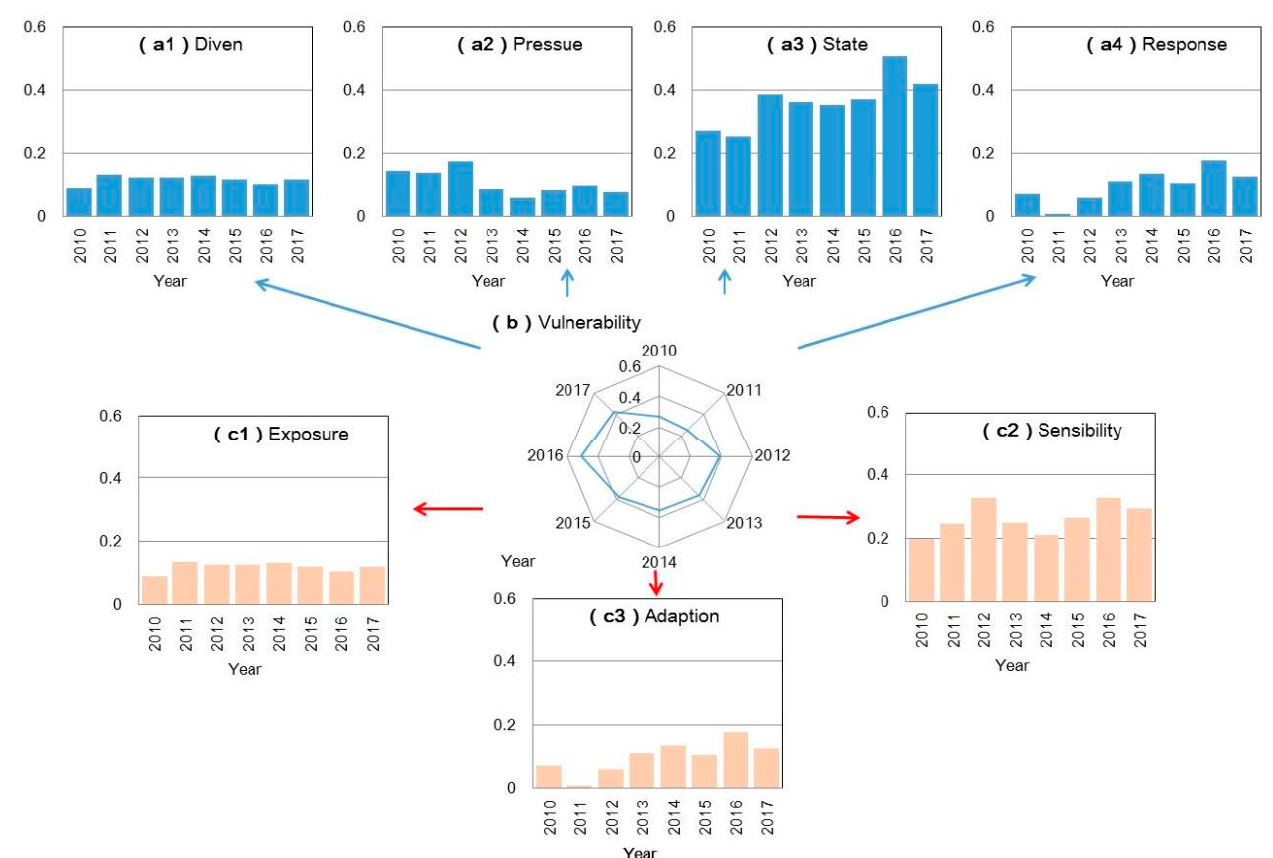
Figure 2. The vulnerability of resources (WEF) from 2000 to 2017 under S0 (without policy adjustment). (( a1 – a4 ) are the measure of vulnerability based on Driver–Pressure–State–Response (DPSR) Model; ( b ) is the total vulnerability level; ( c1 – c3 ) are the exposure, sensitivity, and adaptability levels in vulnerability).